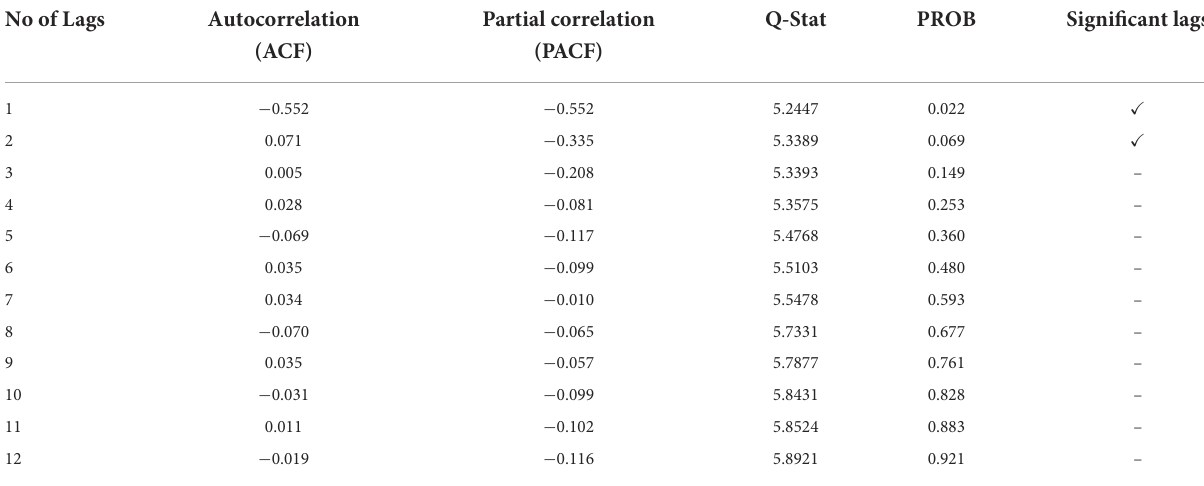
TABLE 4A Correlogram for ARIMA